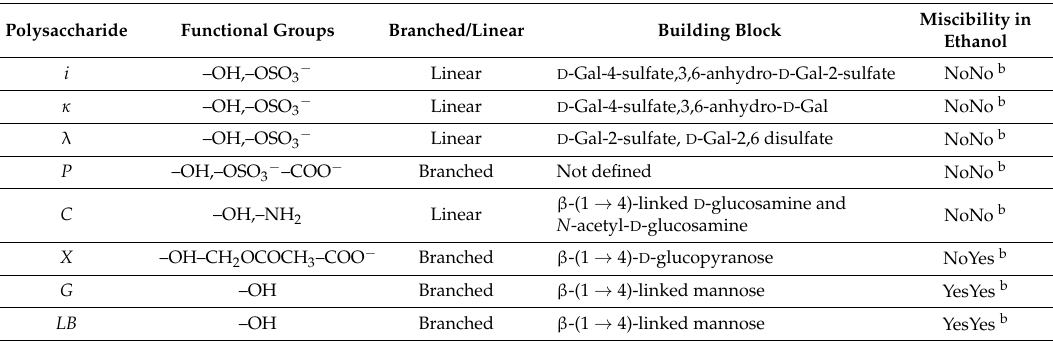
Table 1. Miscibility of polysaccharides in ethanol a